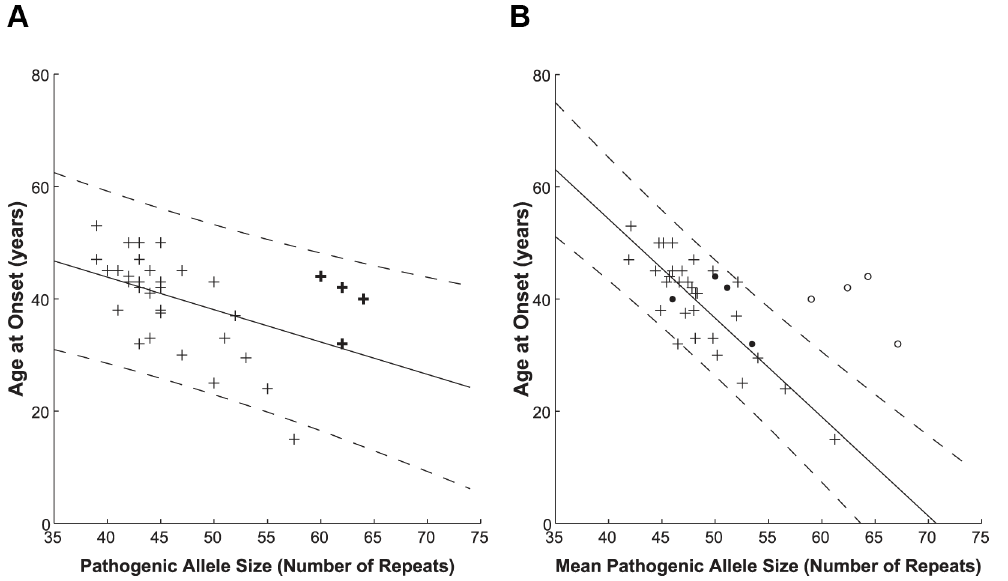
Figure 1. Correlation between polyQ length expansion and age at disease onset. Pathogenic allele size as determined via diagnostic sizing ( A , n =35) and by clone sequencing ( B , n =35). Interrupted alleles are indicated on the diagnostic sizing graph by bold crosses for reference only, since these cannot be differentiated by this method. The clone sequencing approach further sub-divided the patient group into those with primarily uninterrupted (crosses, n =31) and interrupted (open circles – total allele length; filled circles – longest CAG stretch, n =4) allele repeats; these subsets are not distinguished via conventional sizing. A linear model was used to relate the patient’s age at disease onset to their indistinguishable pathogenic allele ( A ) or uninterrupted pathogenic allele ( B ) size. The solid lines depict the fit result while the dashed lines show the prediction bounds at the 95% confidence level. Sequencing of cloned patient alleles produces a higher quality fit with tighter prediction bounds. The data used to prepare this figure may be found in Table S3